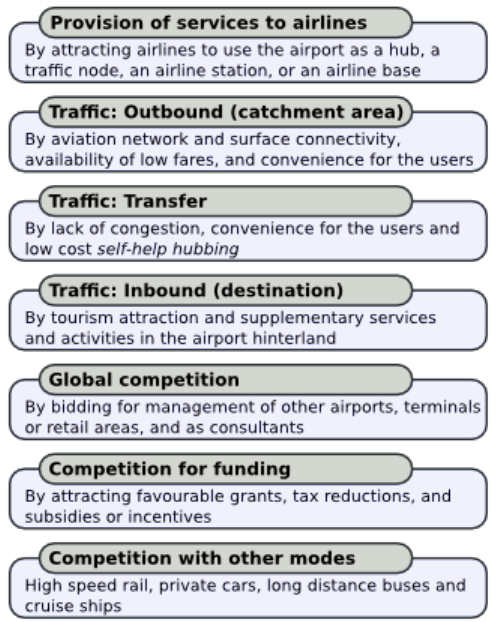
Figure 1 - Summary of the areas of competition for